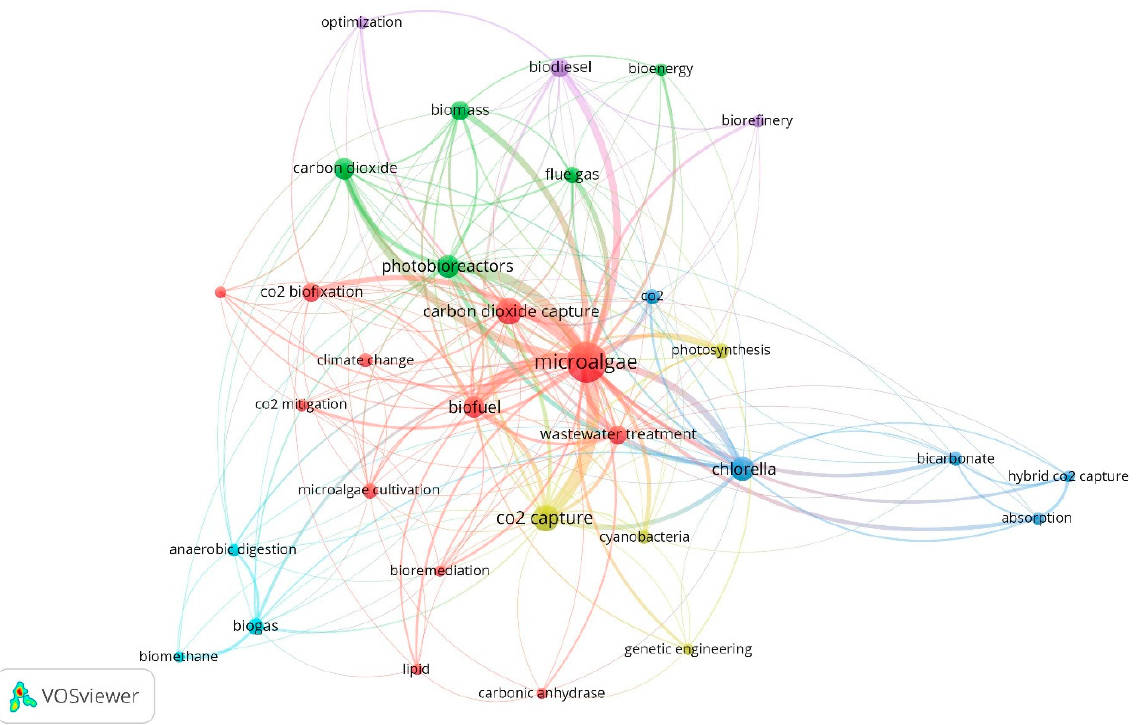
2 capture with microalgae (Bibliometrix).